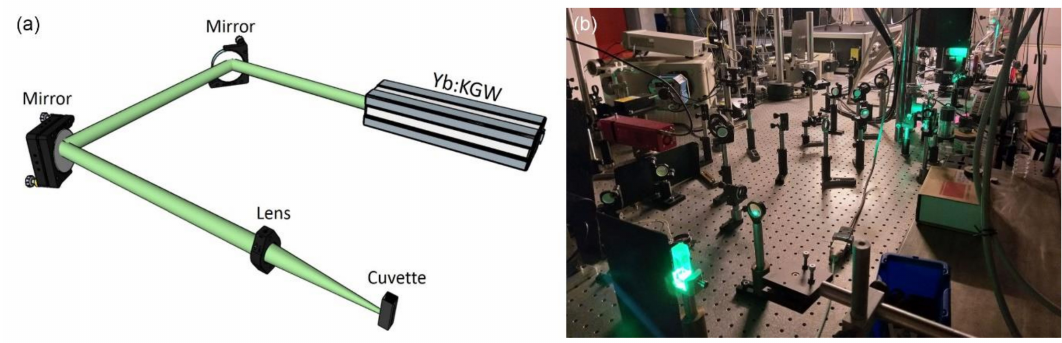
Figure 1. ( a ) Schematic representation and ( b ) photograph of the setup of the photo-induced process using a femtosecond